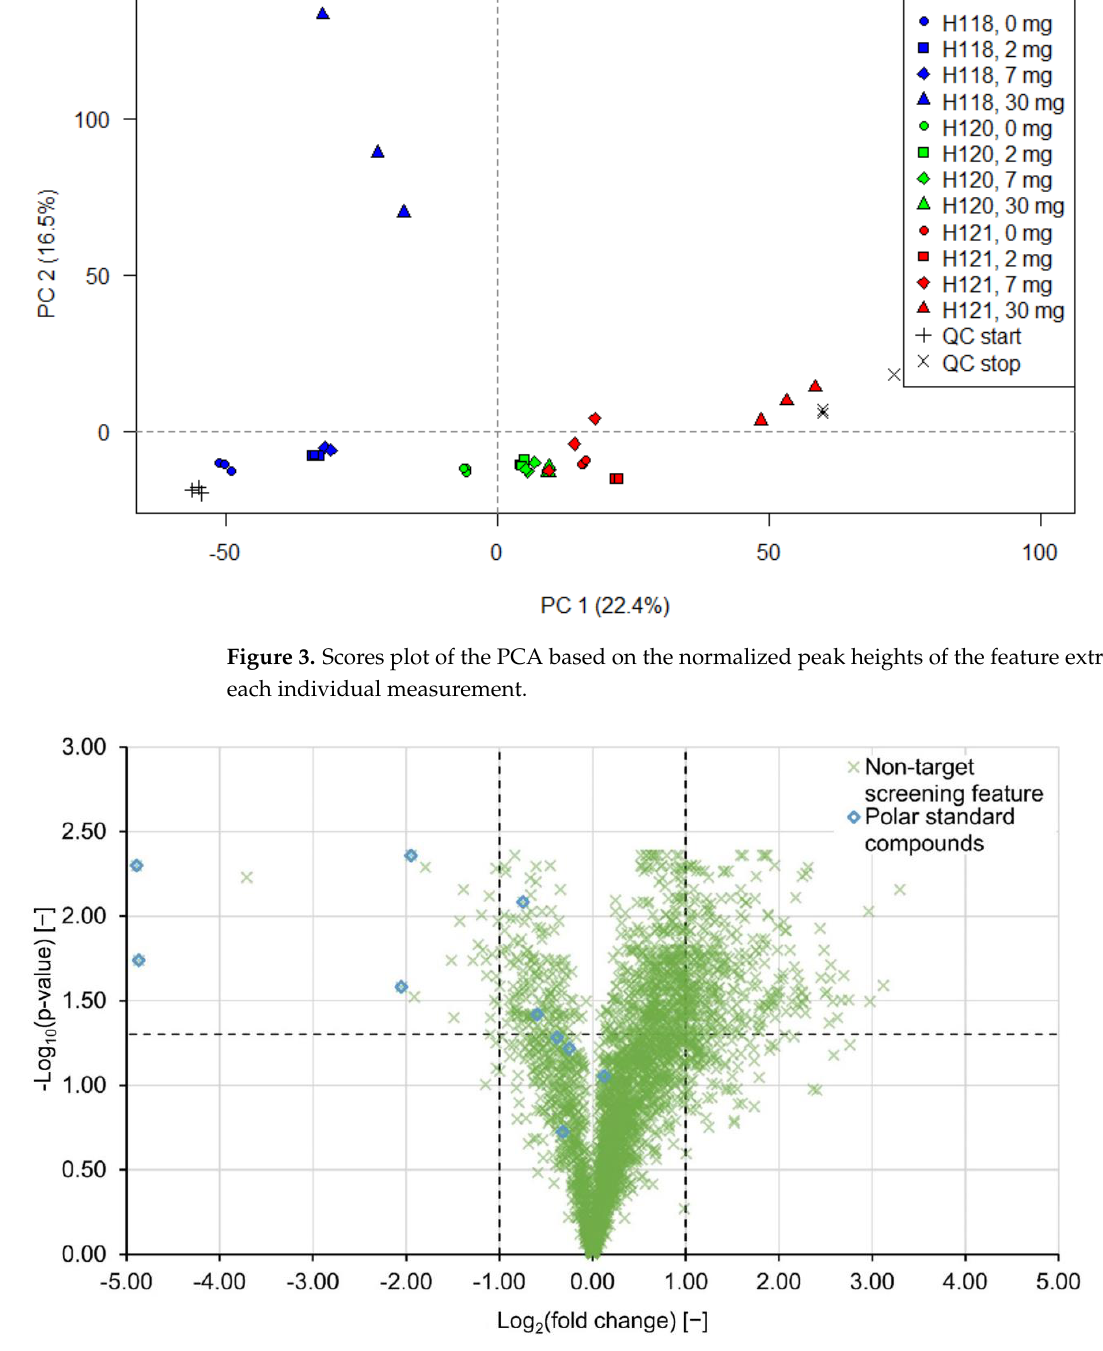
Figure 4. The volcano plot shows features extracted during the comparative analysis of the sample treated with PAC type H121 at 30 mg L −1 and the respective blank sample. The horizontal dashed line marks the cut-off p -value of – log10(0.05) and the vertical dashed lines the consistency interval. Features which were annotated with polar standard compounds are marked with blue diamonds.